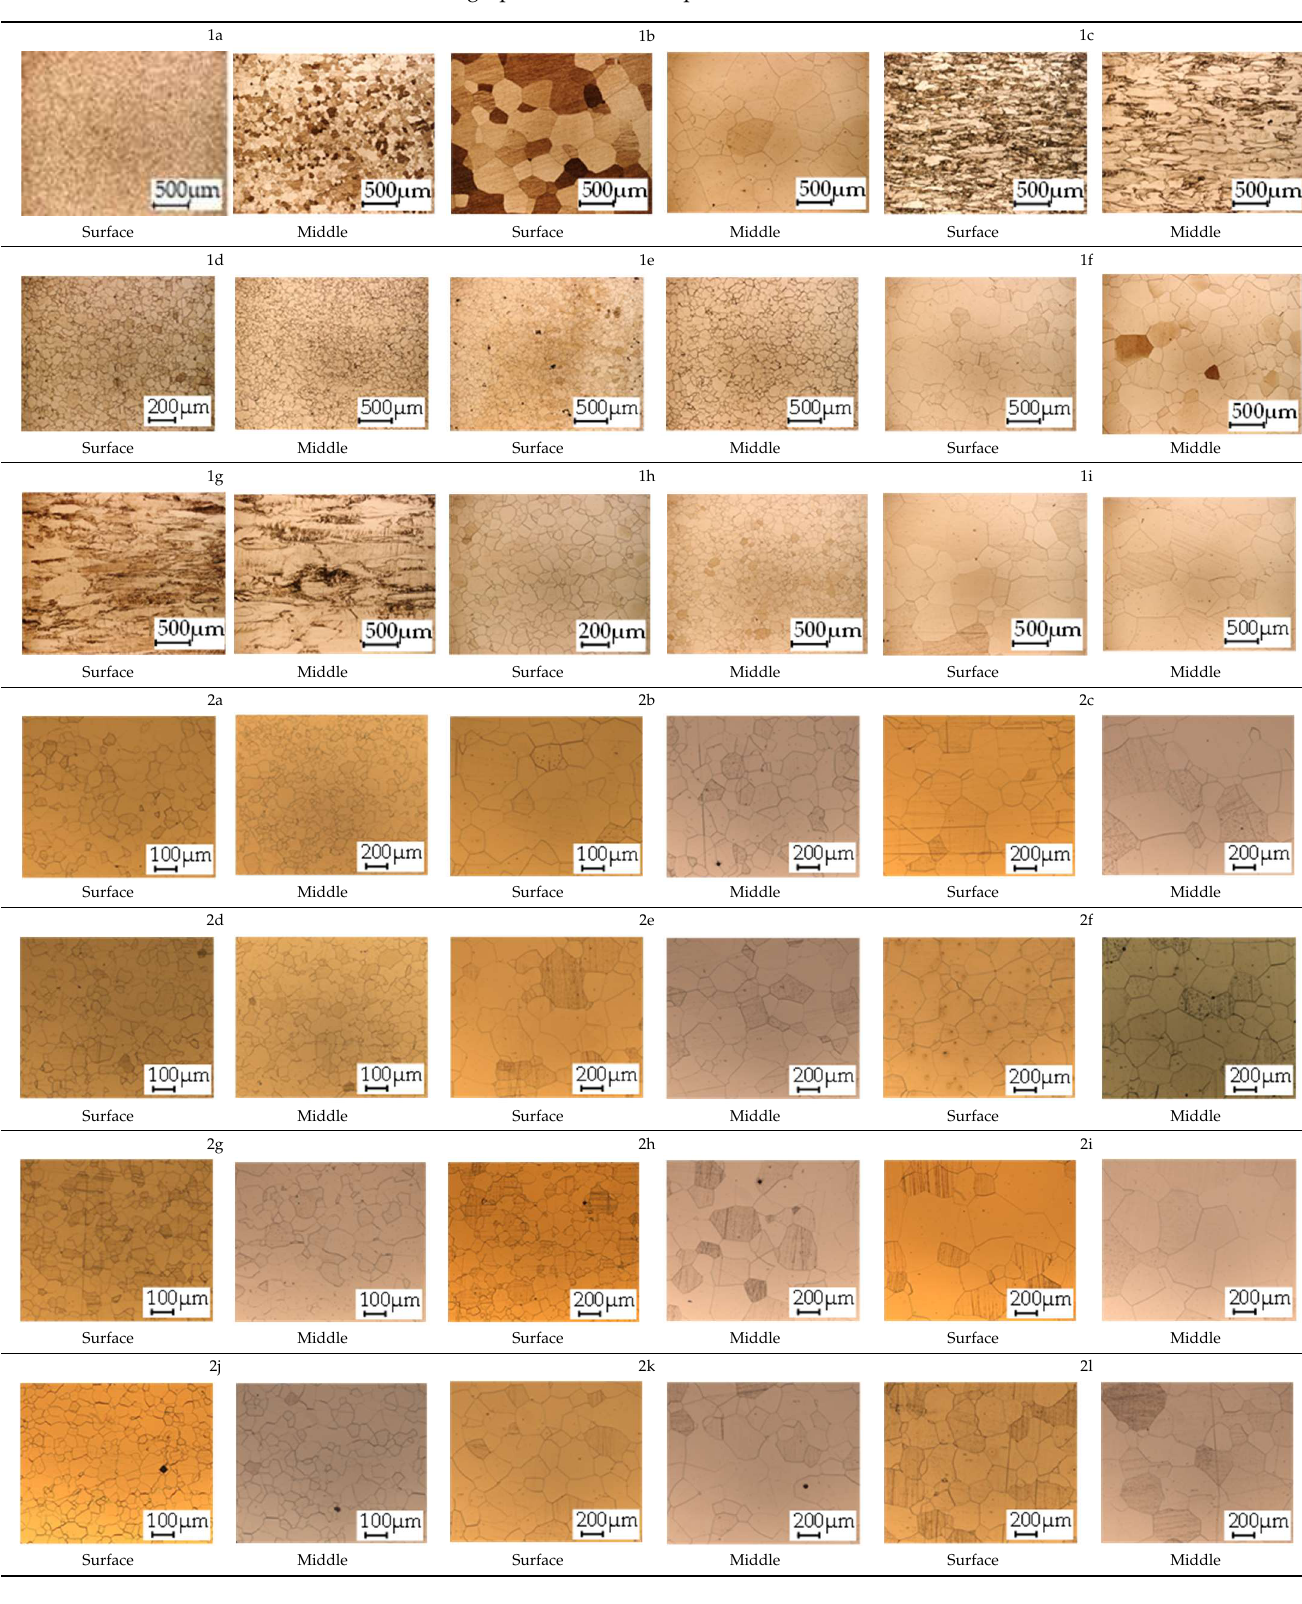
Table 3. Micrographs of the RD–TD plane for all studied materials.